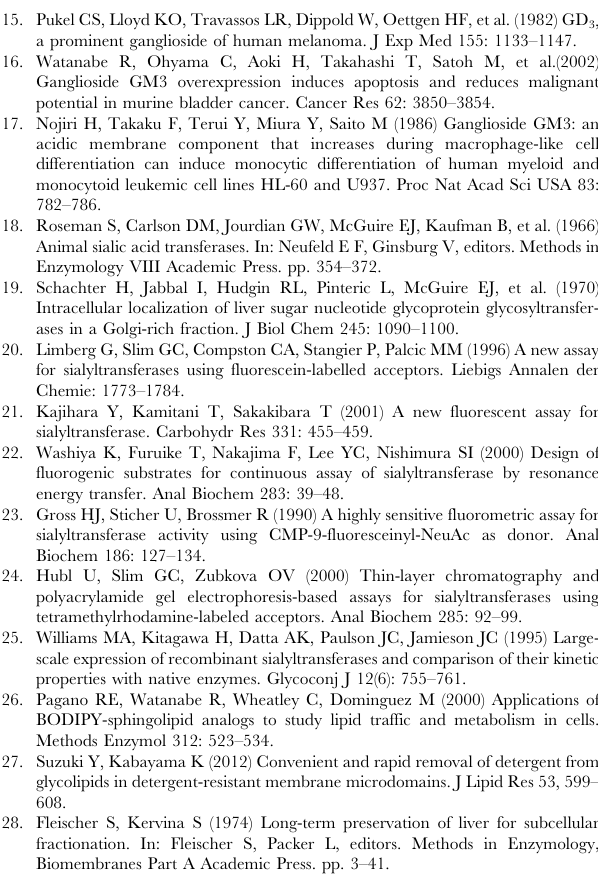
Table S1 Sialyltransferases involved in the biosynthetic pathway of gangliosides. Table S2 preparation of microsomes from different bovine and ovine organs.